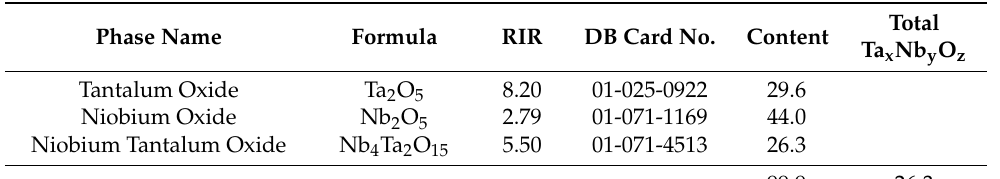
Table 5. Quantitative XRD (phase) analysis results (WPF, combined with RIR) of a 70 mol% Nb 2 O 5